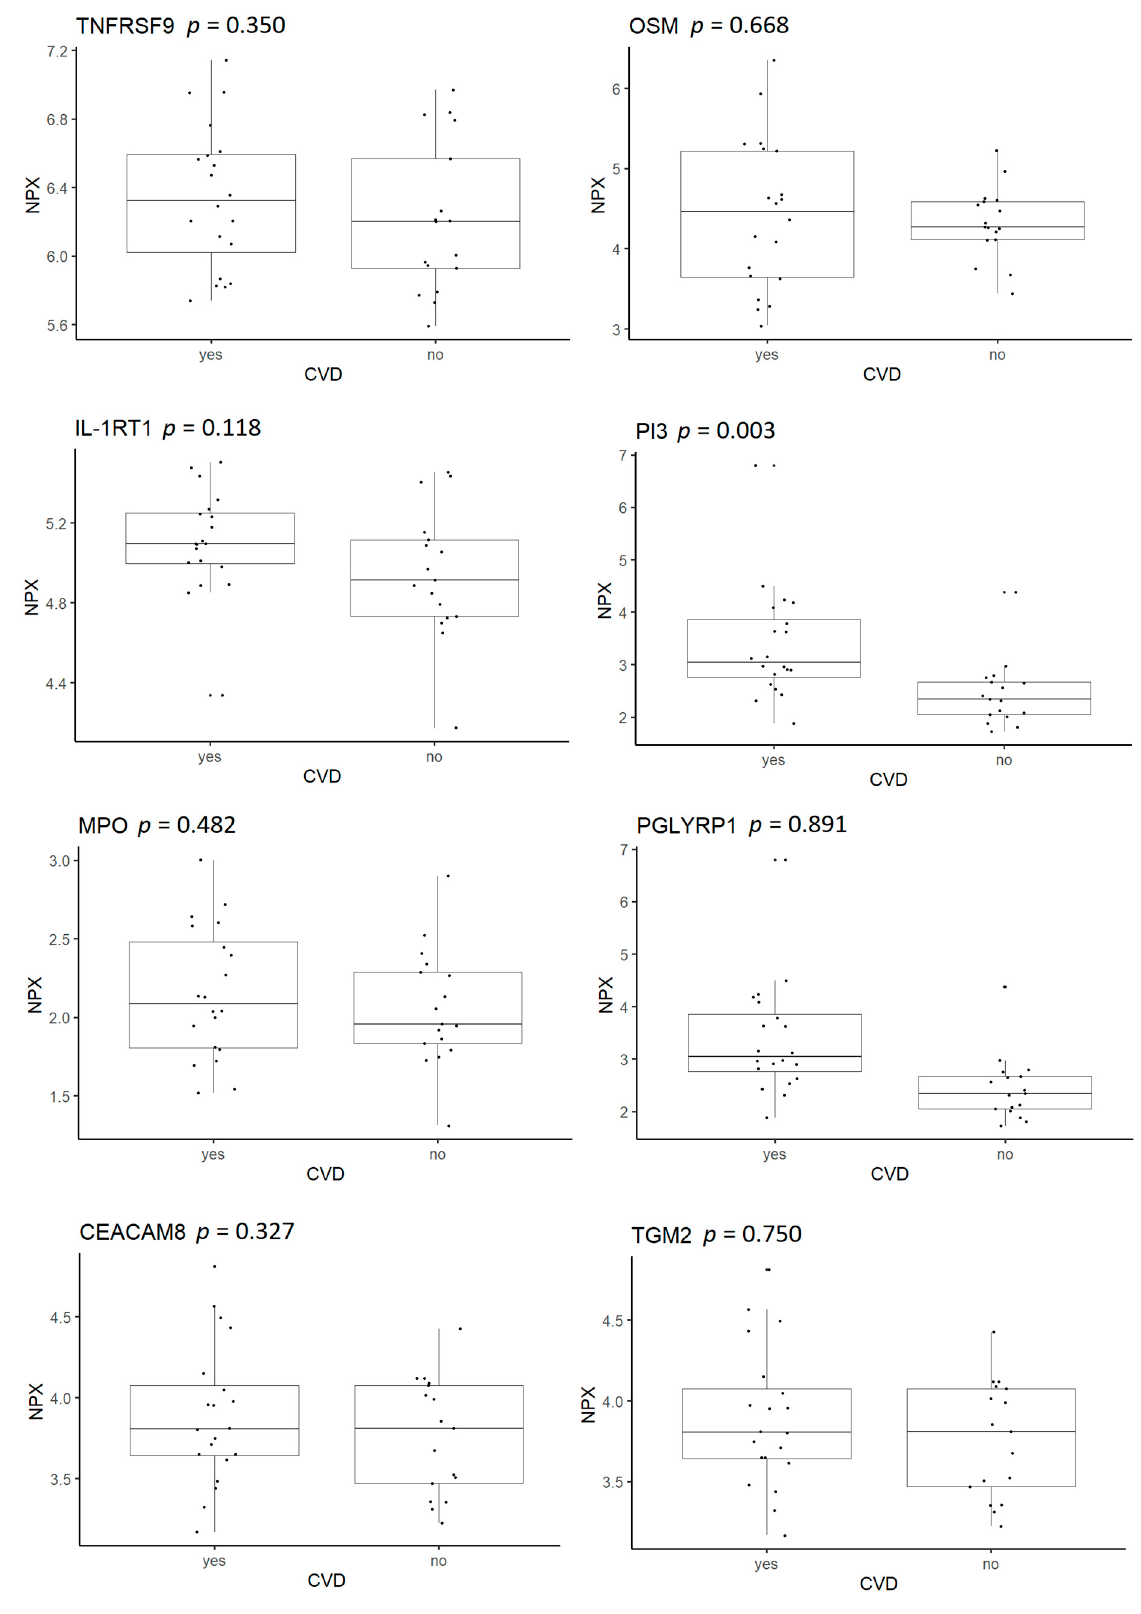
Figure 4. Plasma levels of the proteins TNFRSF9, OSM, IL-1RT1, PI3, MPO, PGLYRP1, CEACAM8 and TGM2 in patients with psoriasis with and without CVD. Boxplots show normalized protein expression (NPX) values of plasma proteins. Significance level, p < 0.05.